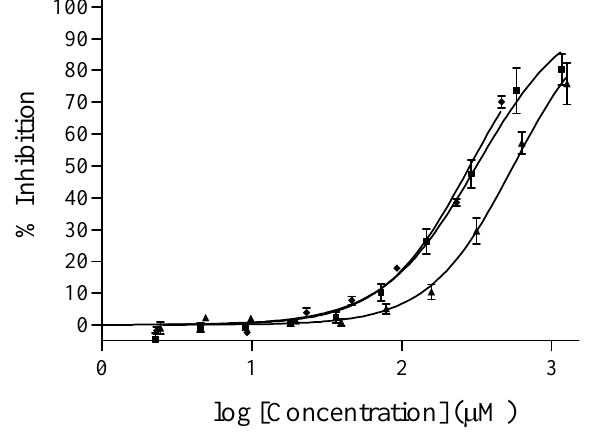
Figure 1. Dose-response titration of ilimaquinone ( (cid:161) ), smenoquinone ( ▲ ) and ethylsmenoquinone ( (cid:160) ) against PPDK. Data points are the mean and SD of 2 (Ilimaquinone) or 4 (smenoquinone and ethylsmenoquinone) individual experiments. The data was fitted with a sigmoidal (Hill) dose response curve of the form ]10[1100 inhibition % is the concentration that causes 50 % += where IC 50 h 50 logX)-(logIC inhibition of PPDK, X is the concentration of the compound, h is the Hill slope and curve fitting is constrained between 0 and 100%